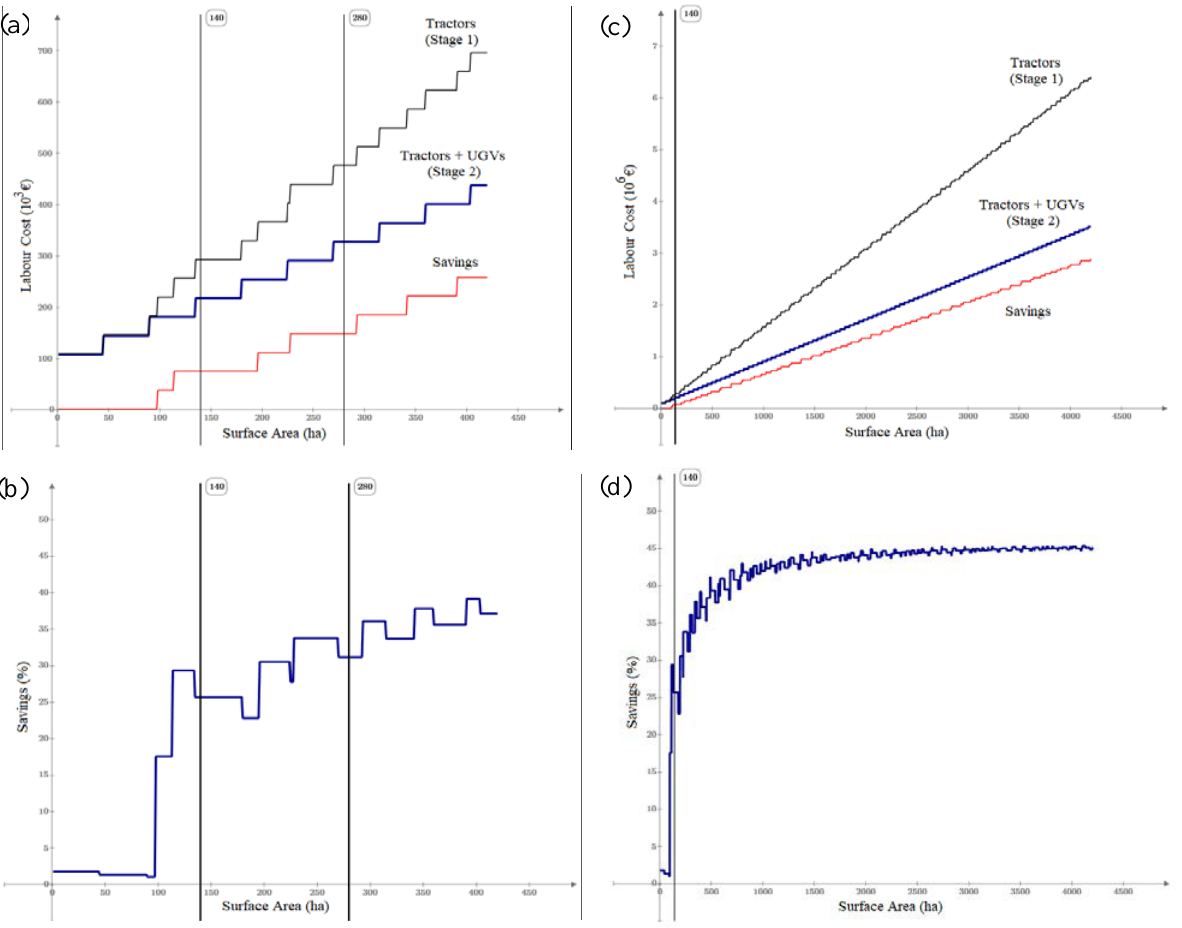
Figure 6. (a) The relationship between the labour costs and surface area of the peat field. (b) Savings in percentage on labour costs when switching from a Stage 1 fleet (tractors only) to a Stage 2 fleet (tractors and UGVs). (c) As the surface area increases to thousands of hectares the linear relationship between the labour costs and surface area of the peat field becomes apparent. (d) As the surface area increases to thousands of hectares the savings in labour costs in percentage for the Stage 2 hybrid fleet will approach an asymptote, in this case ~45 %. All figures here are given for data corresponding for the ‘vacuum harvester’ method and for Estonian